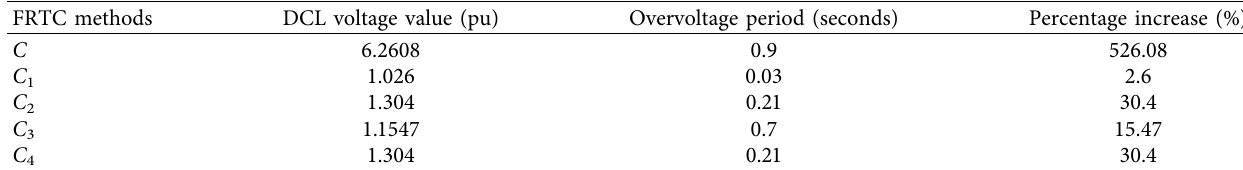
Table 7: Performance comparison of simulated FRTC methods for DCL voltage.